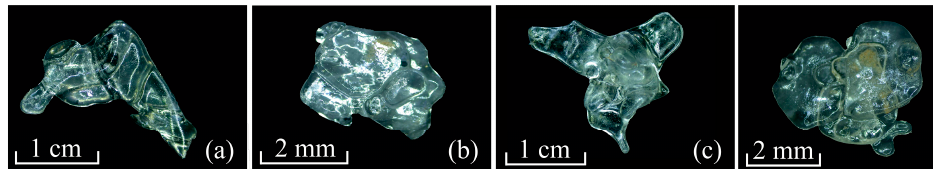
Figure 8. Two frazil particles agglomerated together.